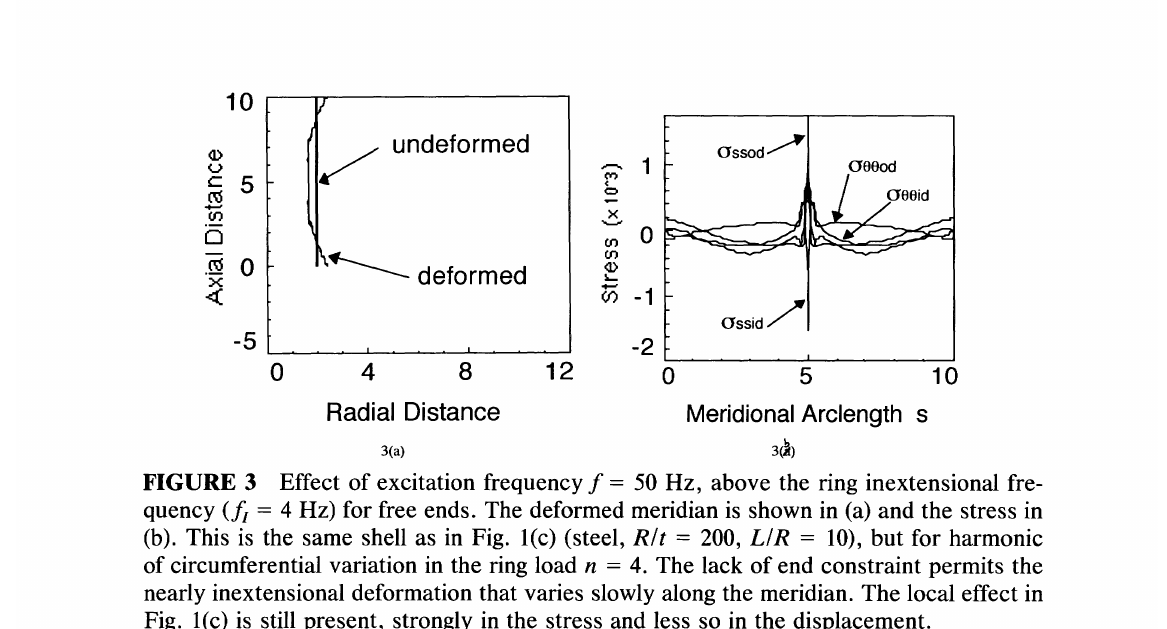
FIGURE 3 Effect of excitation frequency 1 = 50 Hz, above the ring inextensional fre quency (II = 4 Hz) for free ends. The deformed meridian is shown in (a) and the stress in (b). This is the same shell as in Fig. 1(c) (steel, R/t = 200, L/R = 10), but for harmonic of circumferential variation in the ring load n = 4. The lack of end constraint permits